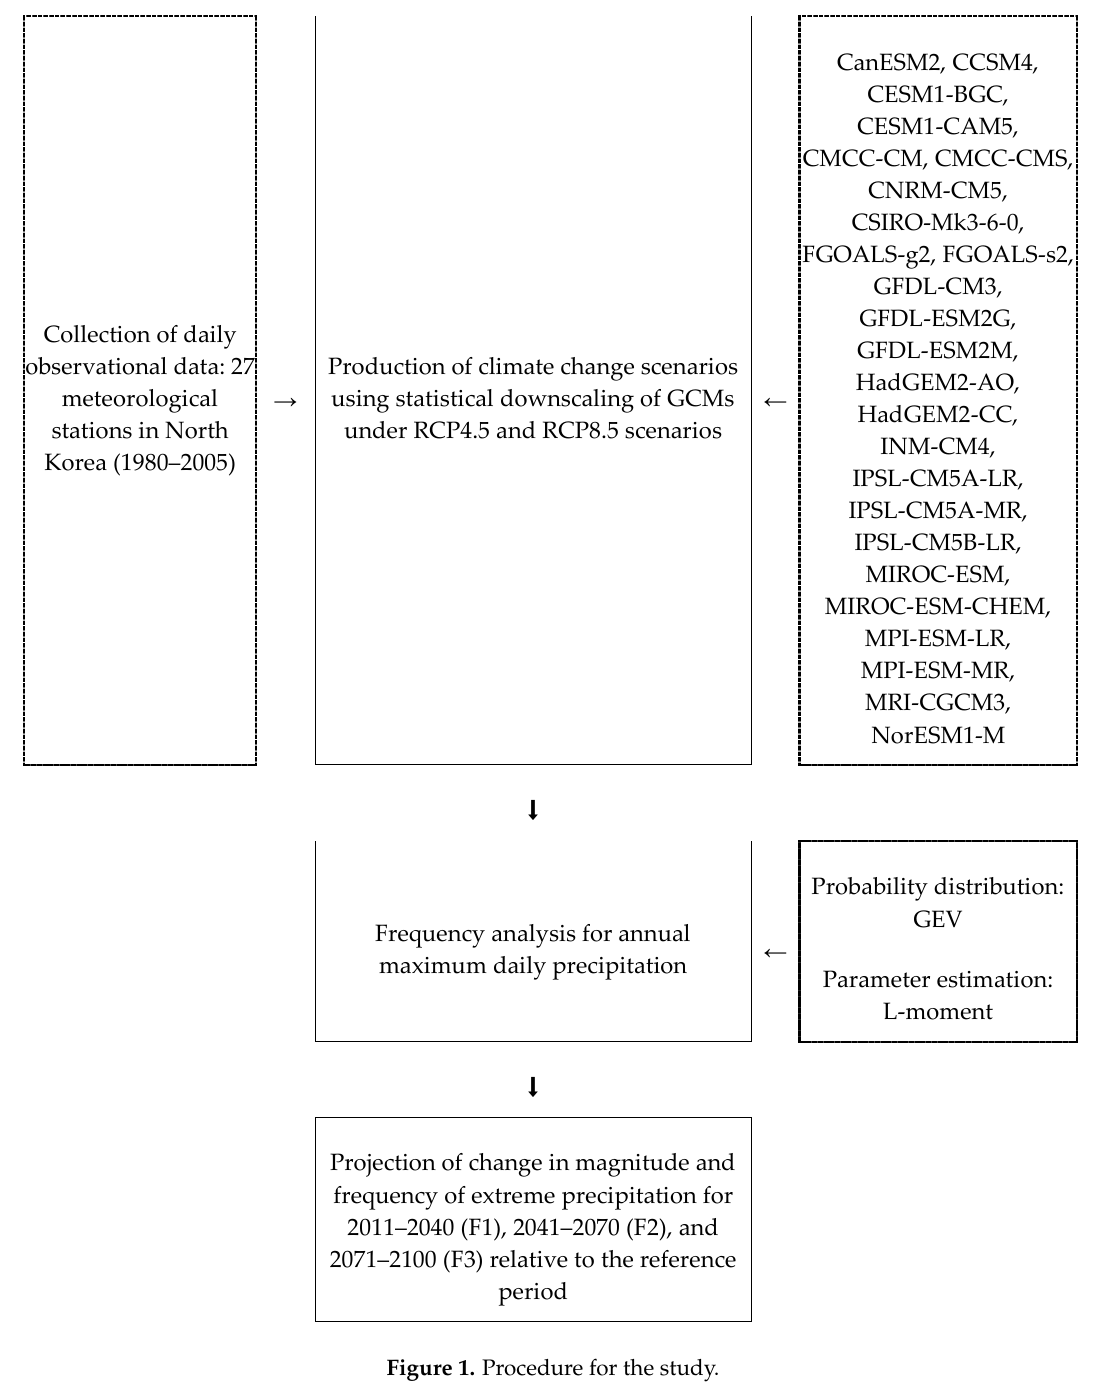
Figure 1. Procedure for the study.